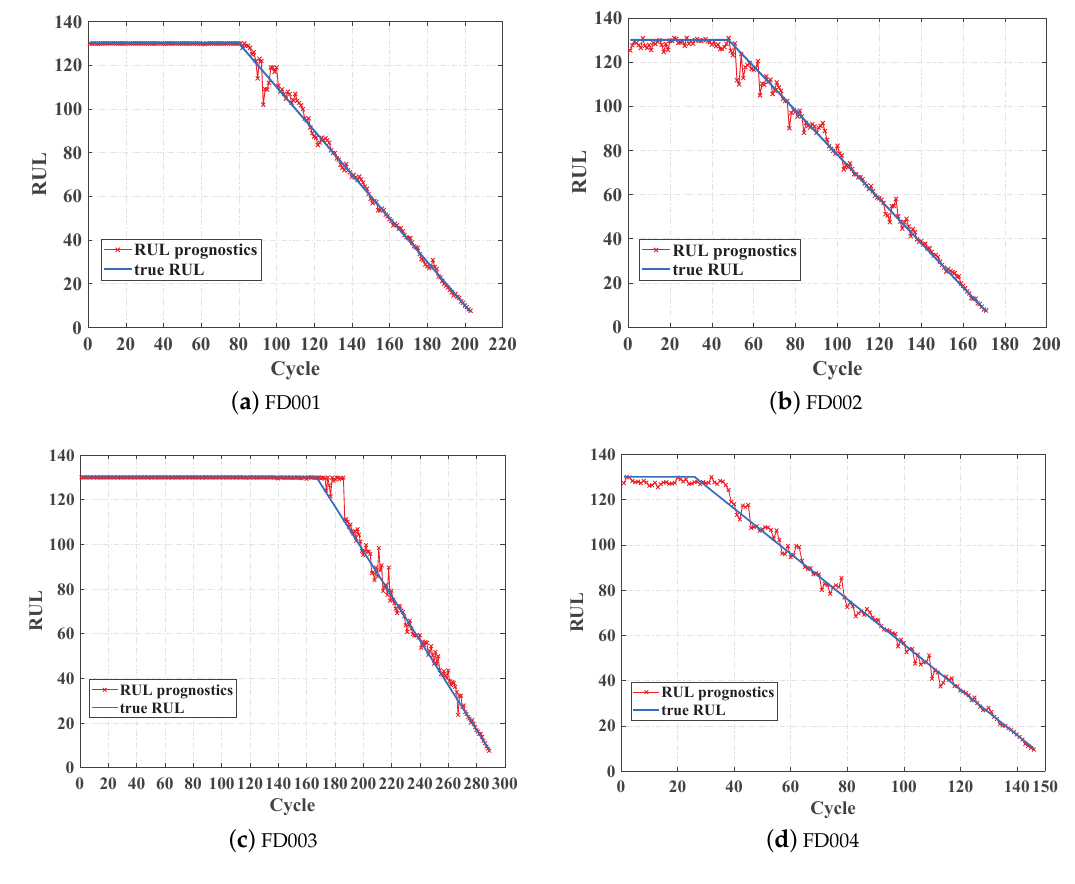
Figure 9. Model comparison.